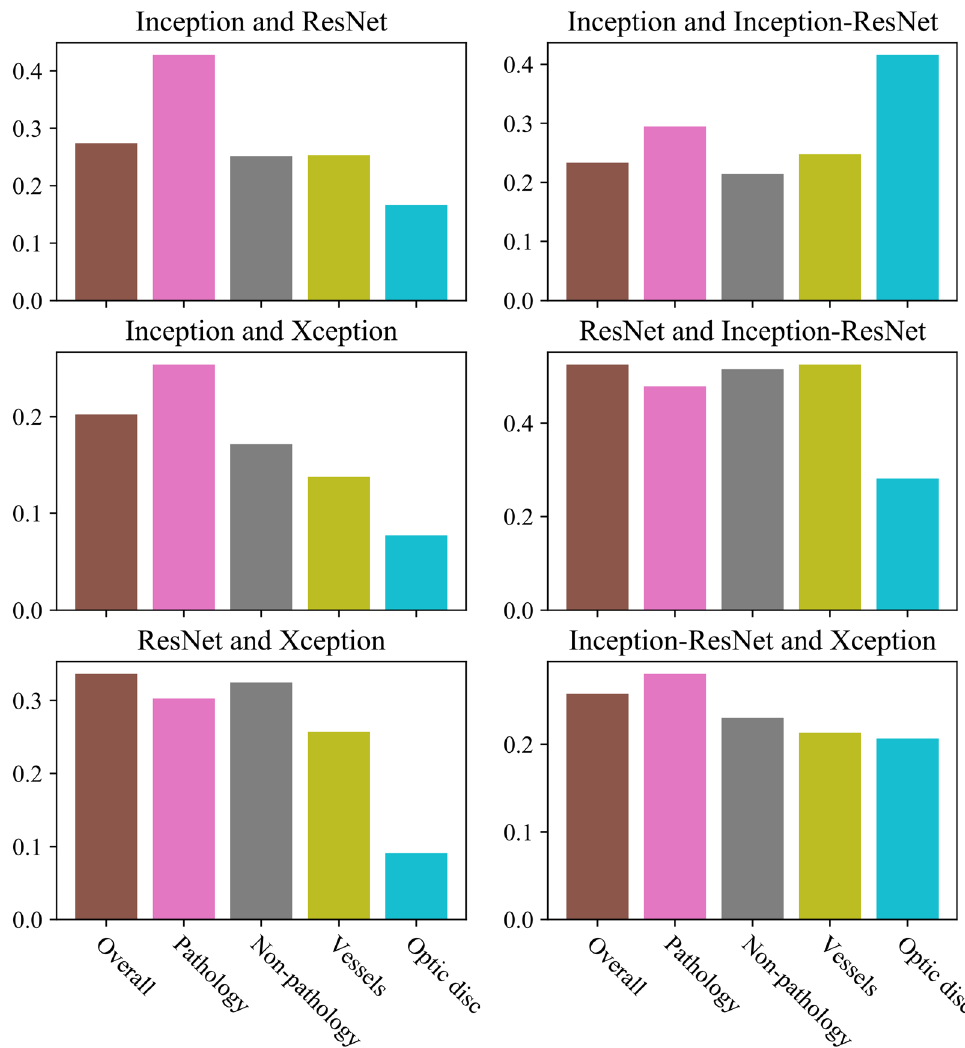
Figure 5. Mutual agreement of different CNNs when compared directly in the visualization map